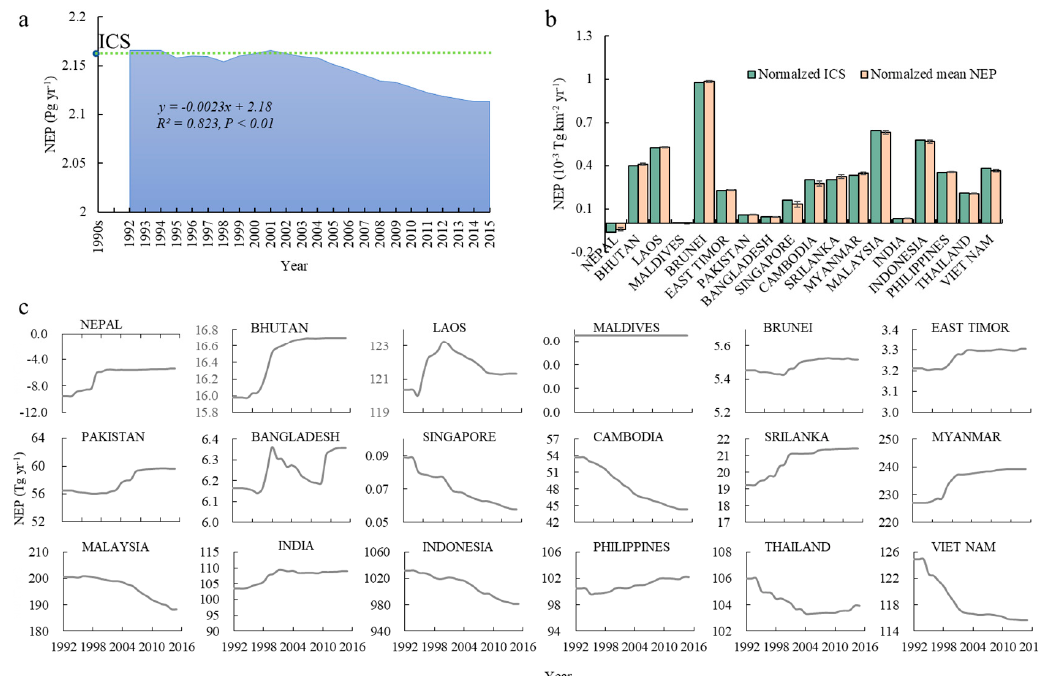
Figure 3. Values of NEP in the study area during 1992–2015. ( a ) Annual values of NEP in South and Southeast Asia; ( b ) annual values of NEP for all 18 countries; ( c ) initial level of carbon sequestration (ICS) and annual difference (AD) values of all 18 countries. The NEP of Maldives is zero due to its pocket land area.